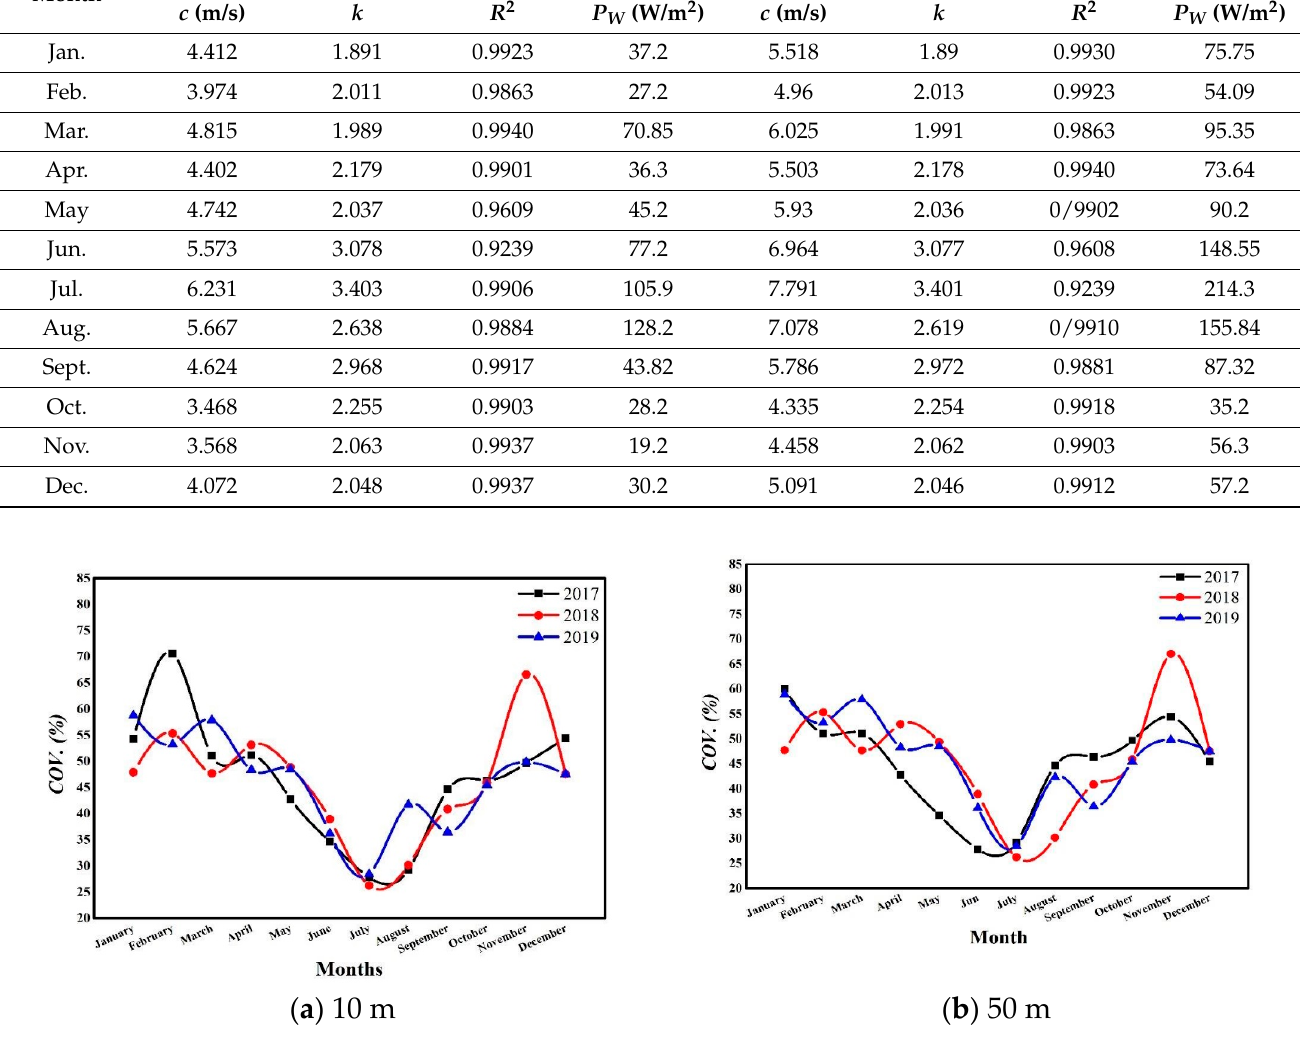
Figure 5. Hourly of mean ( COV ) of turbulence at 10 and 50 m height. Table 12. The average error between the annual wind power densities calculated using measured data and those estimated by Weibull distribution